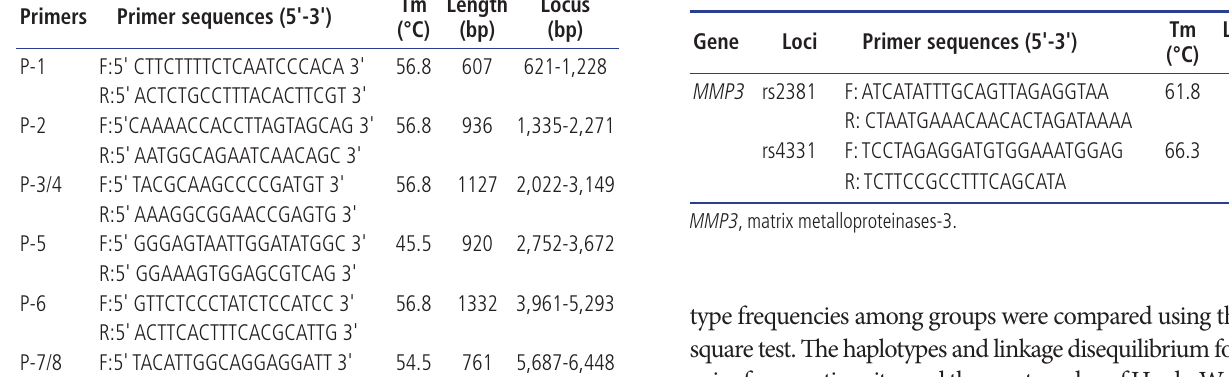
Table 2. Information of primer sequences for genotyping mutations by high- resolution melting Gene Loci